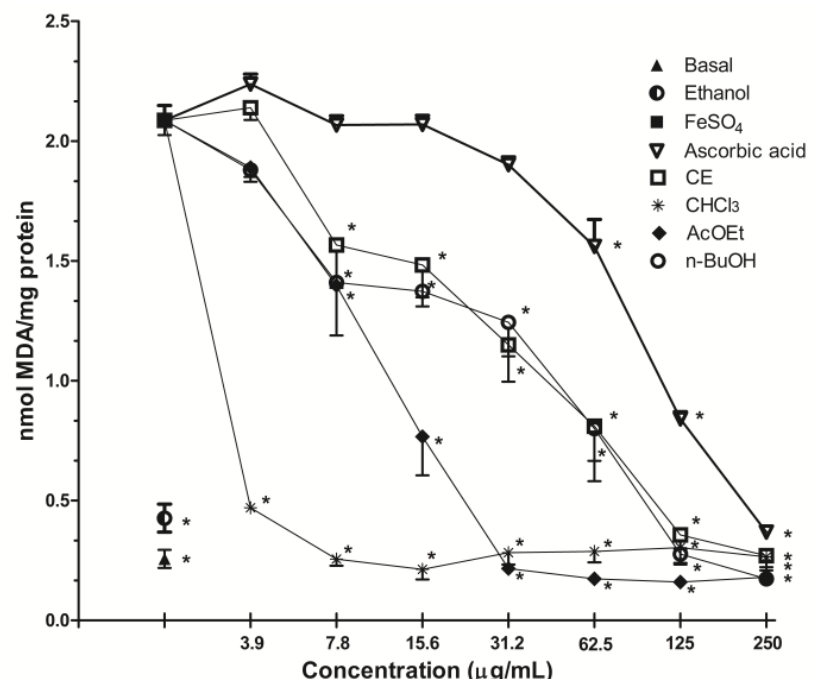
Figure 3. Effect of S. guaraniticum CE and fractions on TBARS production in supernatant of rat brain